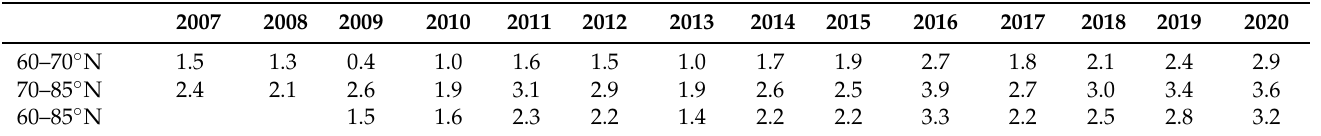
Table 1. Annual mean surface air temperature anomalies averaged over latitude ranges of 60–70, 70–85, and 60–85 ◦ N, relative to the average for the period 1961–1990 based on the results of the analysis of observations